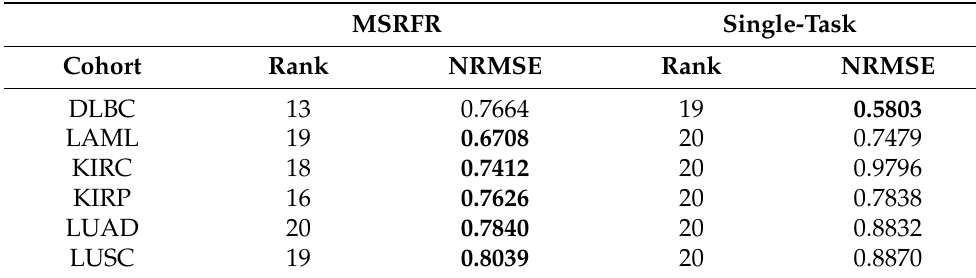
Figure 2. Heat map of top 10 miRNAs and top 50 mRNAs of as ( a ) cohort-specific regulatory module identified in KIRC and ( b ) tissue-specific regulatory module identified for kidney, clustered into two groups of patients using k -means clustering on mRNA expression values. Red colors indicate over-expression (i.e., higher than the population mean), and blue colors indicate lower expression (i.e., lower than the population mean). The font sizes of miRNAs and mRNAs are proportional to the magnitudes of their weights inferred by our algorithm. Table 2. Predictive performance values of MSRFR vs. single-task algorithm on six data sets incor- porated in this study, in terms of average NRMSE over mRNAs and their selected ranks. Improved performance is highlighted with bold